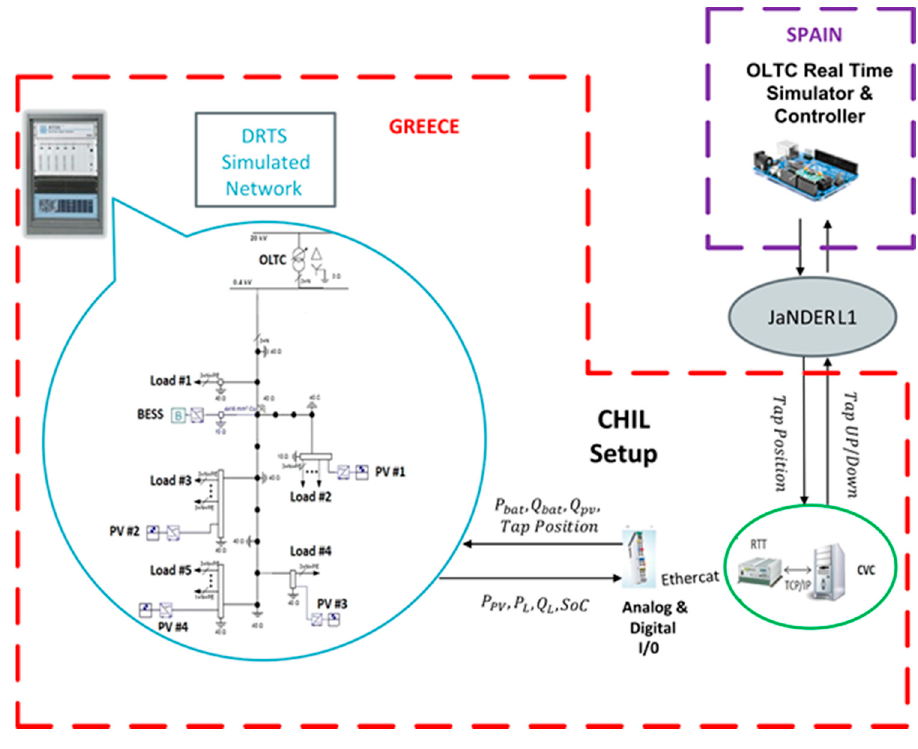
Figure 12. Test setup using JaNDER.